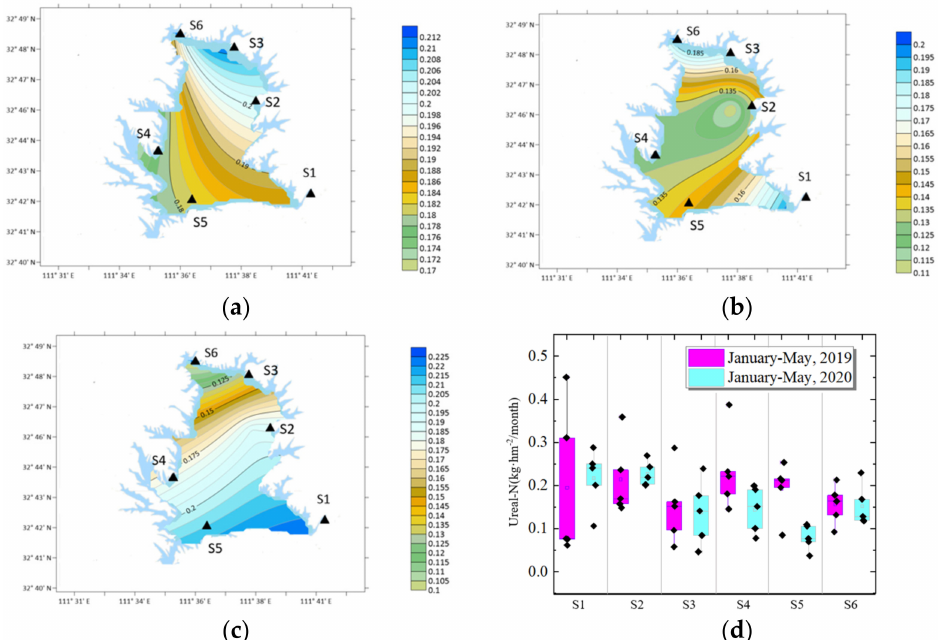
Figure 10. Urea-N distribution around COVID-19 lockdown. ( a ) Before lockdown; ( b ) middle lockdown; ( c ) after lockdown; ( d ) Urea-N compared with 2019.